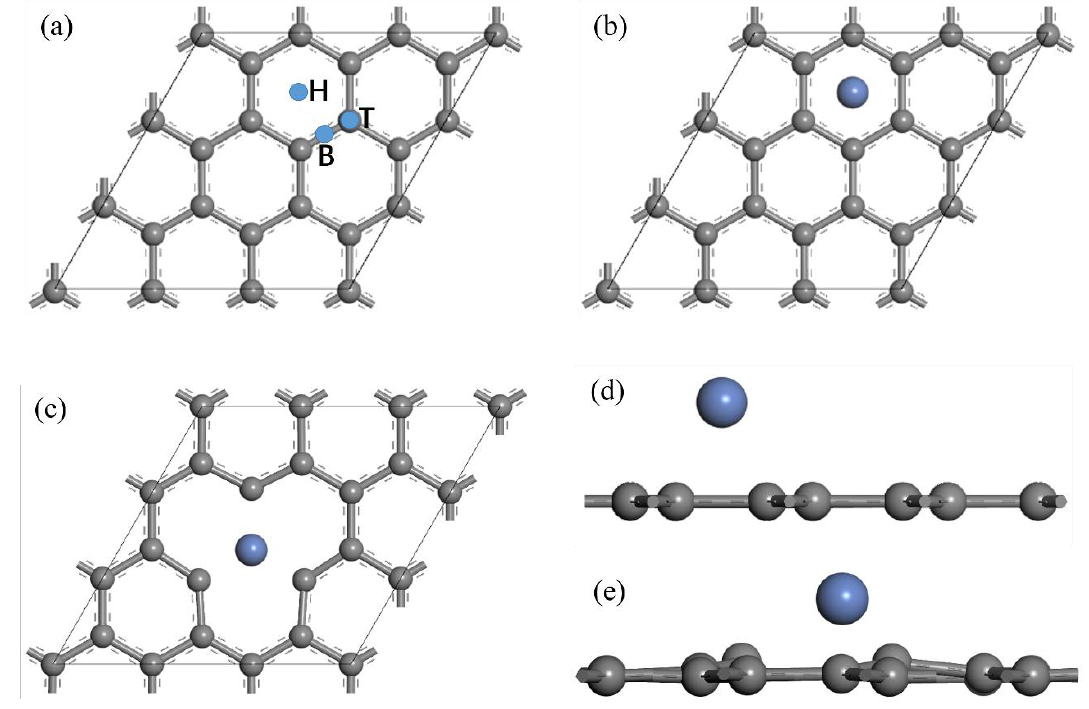
Figure 9. The model of the Ni atom adsorbed on the surface of the GNSs. ( a ) Three highly symmetrical sites suitable for the adsorption of metal atoms, ( b ) the adsorption model of the Ni atom on the perfect GNSs and ( c ) on the defective GNSs, and ( d ) the adsorption height of Ni atom on the perfect GNSs and ( e ) on the defective GNSs.